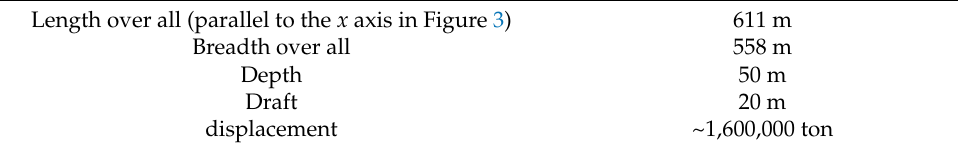
Table 2. Ship’s specifications.